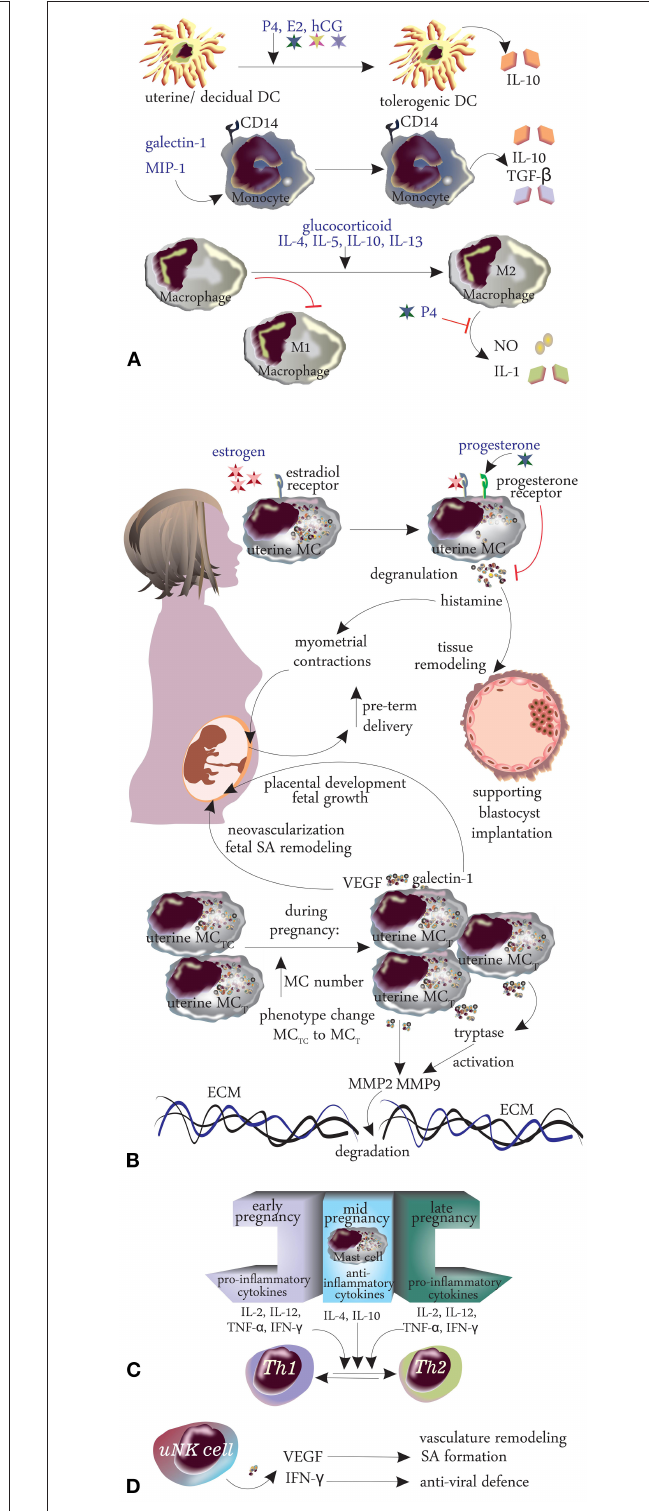
FIGURE 2 | Effects of various hormonal changes on the immune system during pregnancy.